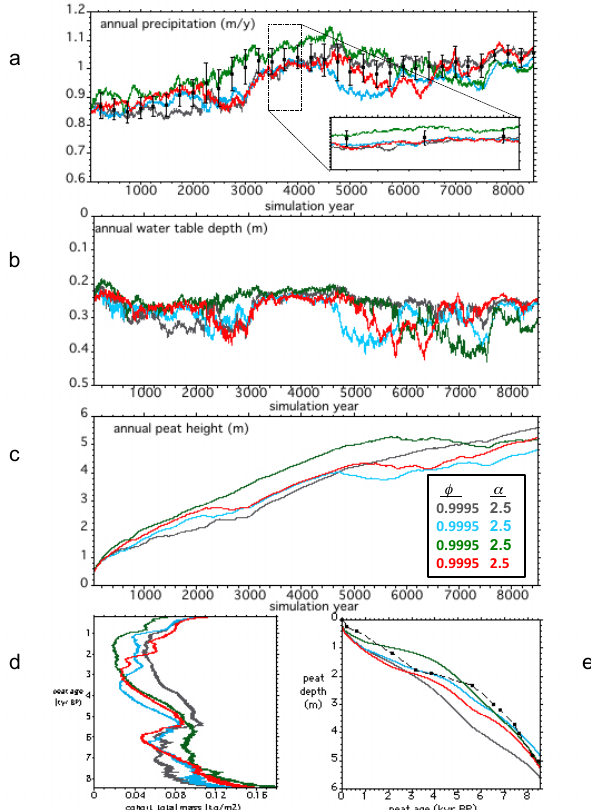
Fig. 9. Same as Fig. 7, but for four simulations with α =2.5 and φ =0.9995 (see text and Eqs. 19, 20). In base runs (Figs. 4–6) φ